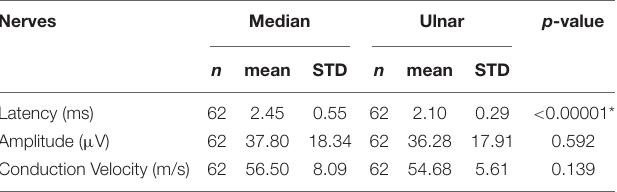
TABLE 1 | Mean standard sensory conduction parameters in the median and ulnar nerves.